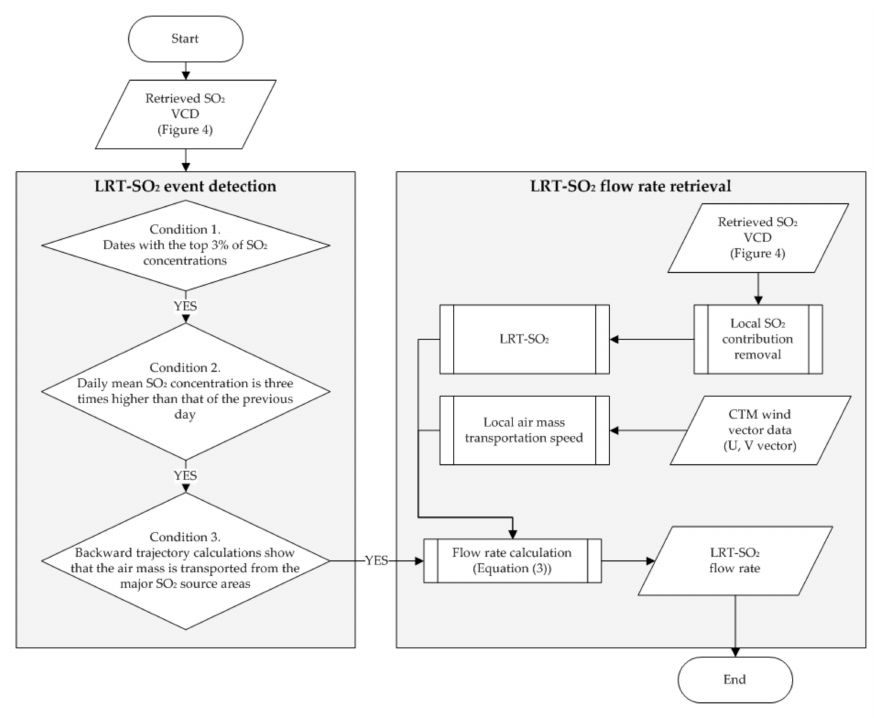
Figure 7. Flowchart of LRT-SO 2 detection and flow rate calculations. The detection and flow rate calculation methods are the same as those of Park et al. [42] but for synthetic